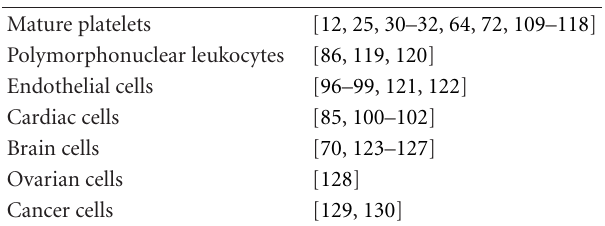
Table 1: List of publications describing biological functions of TPO/c-MPL system apart from hematopoietic